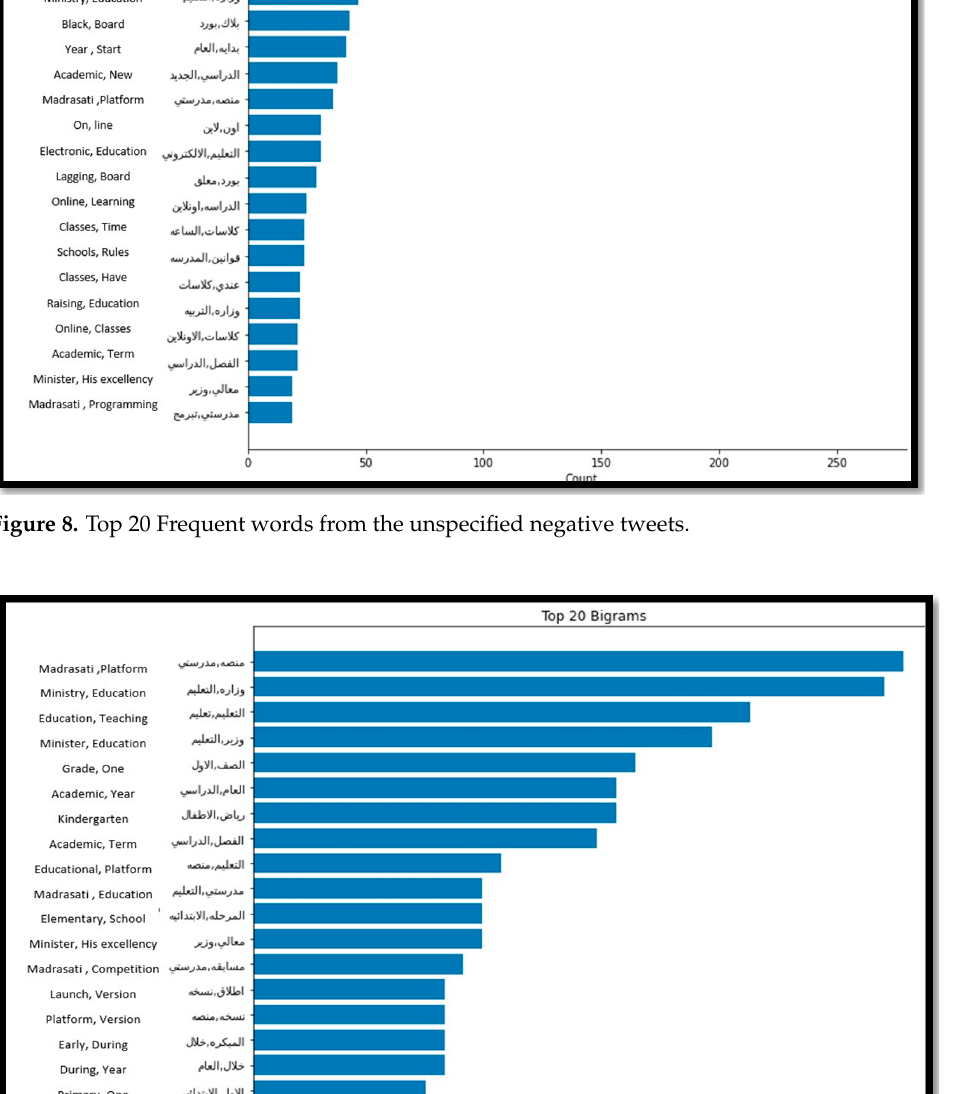
Figure 8. Top 20 Frequent words from the unspecified negative tweets.